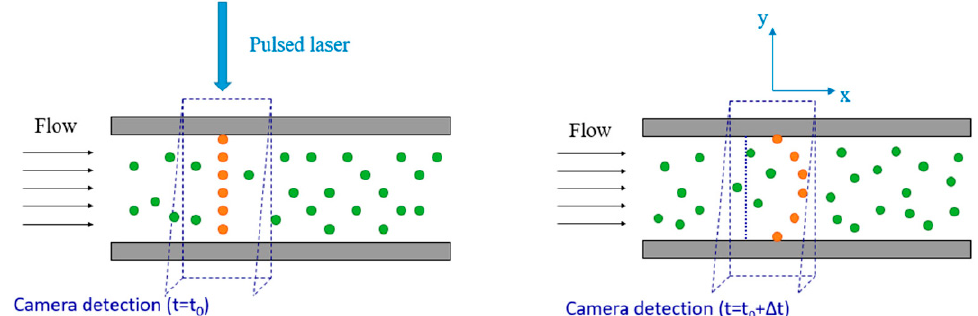
Figure 29. Basic principle of 1D-molecular tagging velocimetry (MTV) by direct phosphorescence for gas flowing in a plane channel from left to right, schematized by Fratantonio et al. [162]. Article published with open access.